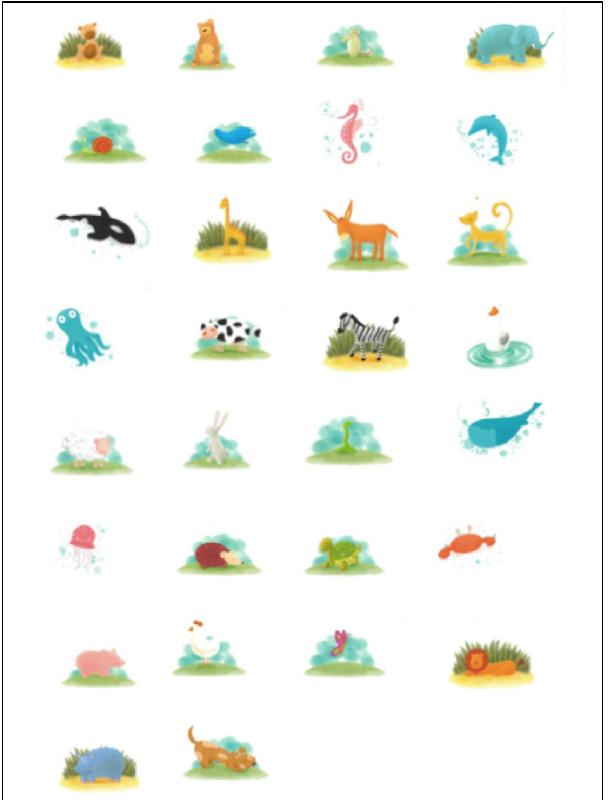
Figure 3. Pictorial-Based Declarative Memory Questionnaire [61]: Series of 30 colorful pictures of common animals that children should remember without looking at the pictures (see methodology section for more details).